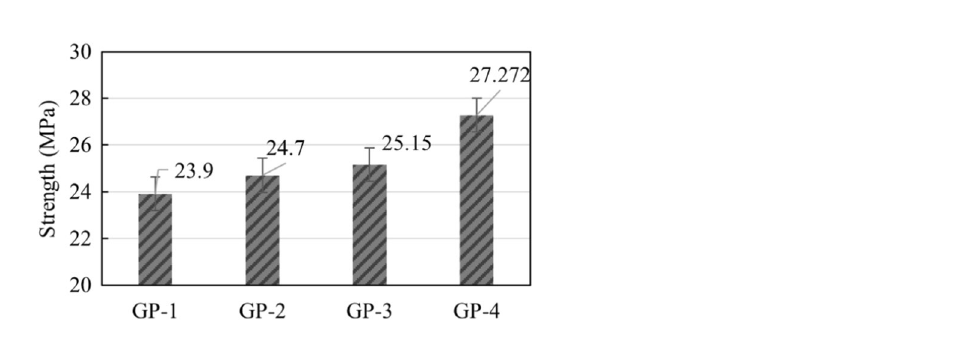
Figure 10. Compressive Strength of the synthesized geopolymer specimens (GP-1 = 15%, GP-2 = 10%, GP-3 = 5% and GP-4 =